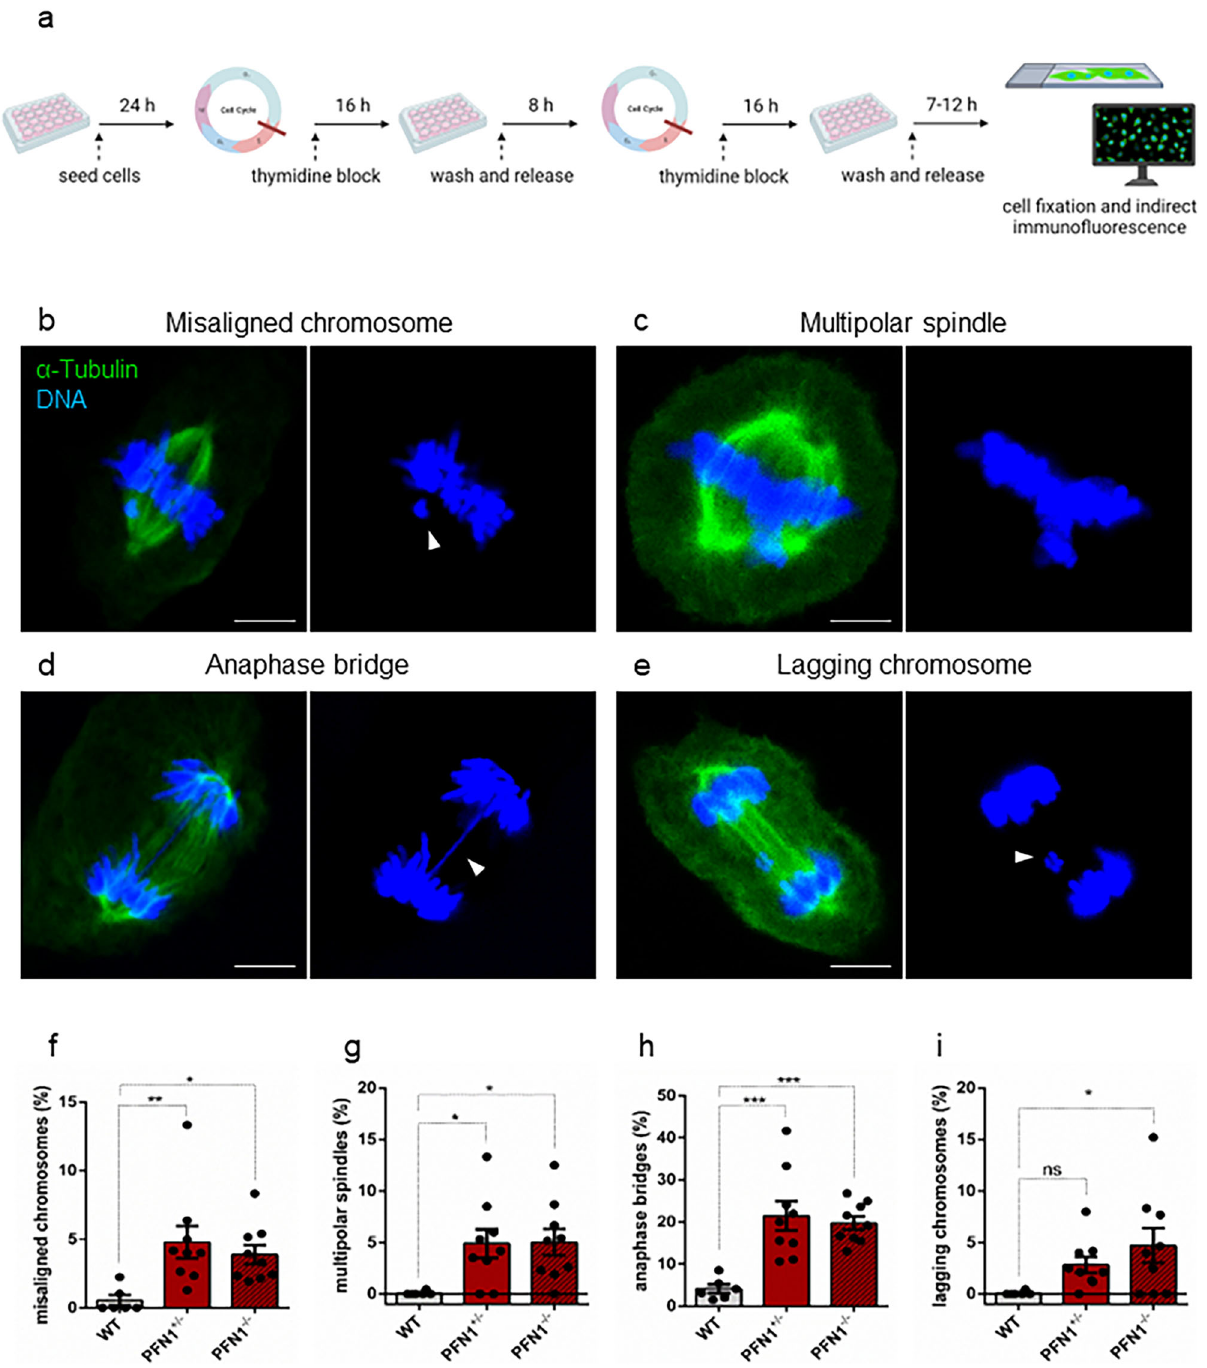
Fig. 4 Chromosome segregation defects in Pro fi lin 1-de fi cient RPE1 cells. a Schematic of the experiment created in BioRender (https://biorender.com/) by F.S.d.C. as a registered user. Below, representative immuno fl uorescence images of mitotic PFN1 -KO RPE1 cells showing b chromosome misalignment (arrowhead) at the metaphase plate, c multipolar spindle formation, d a chromosome bridge (arrowhead) persisting in late anaphase, e telophase with a lagging chromosome (arrowhead). Cells were stained for microtubules ( α -tubulin, green) and DNA (Hoechst 33342, blue); scale bars 5 µ m. In each panel, the overlay shows α -tubulin/DNA staining. Control metaphase, anaphase, and telophase images of dividing RPE1 cells are illustrated in Fig. 1. f Quanti fi cation (%) of cells with misaligned chromosomes; ** P = 0.0096, * P = 0.0411. g Quanti fi cation (%) of cells with multipolar spindles; * P = 0.0305, * P = 0.0259. h Quanti fi cation (%) of cells with anaphase bridges; *** P = 0.0003, *** P = 0.0009. i Quanti fi cation (%) of cells with lagging chromosomes; ns P = 0.2457, * P = 0.0345. Data in f – i are shown as mean ± s.e.m. of three independent experiments ( n = 2 biological replicates for WT, 3 for PFN1 + / − , 3 for PFN1 − / − cells); dots represent the value of each experiment (scoring 911, 825 and 616 total mitoses in WT, PFN1 + / − and PFN1 − / − samples, respectively); range of number of cells used for each individual experiment: 70-266 WT, 30-189 PFN1 + / − , 24-116 PFN1 − / − . Ordinary one-way ANOVA